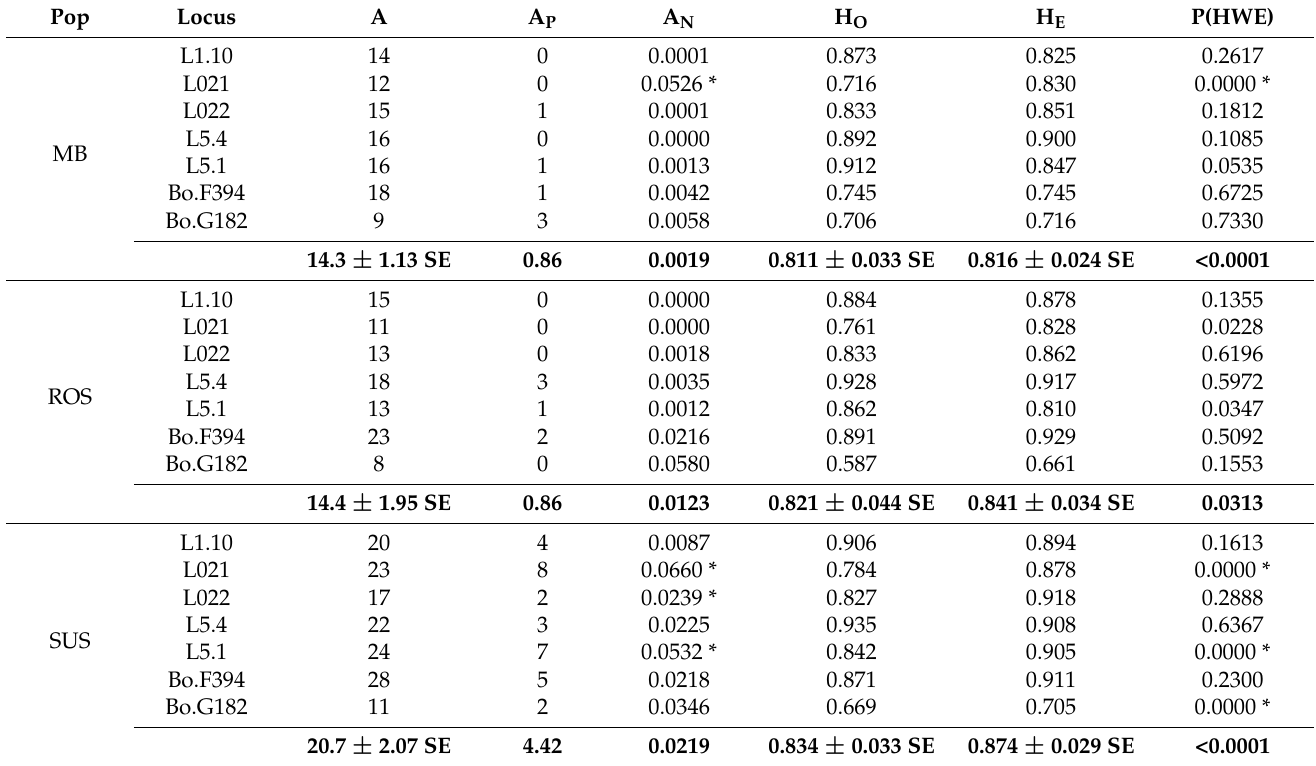
Table 2. Genetic diversity parameters and inbreeding coefficient in studied B. humilis populations. Pop—population, A—number of alleles, A P —number of private alleles, A N —frequency of null alleles, H O —observed heterozygosity, H E —expected heterozygosity, and P(HWE)— p value for HWE.